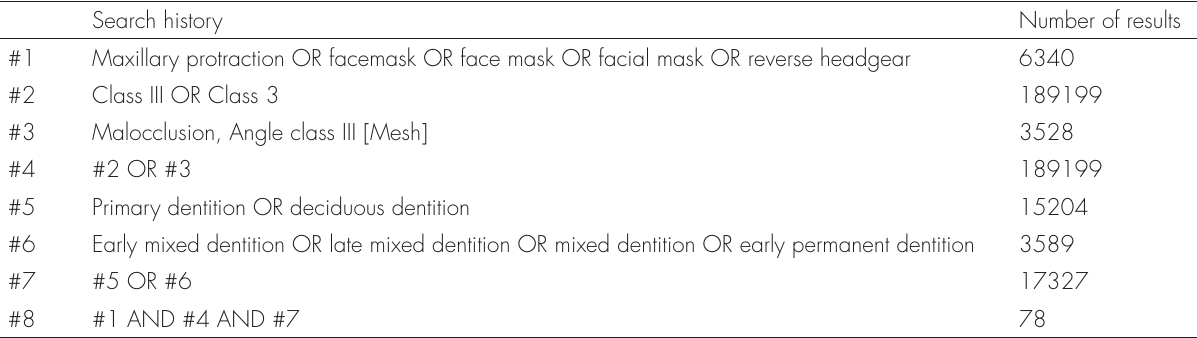
Table I. Search strategy used for